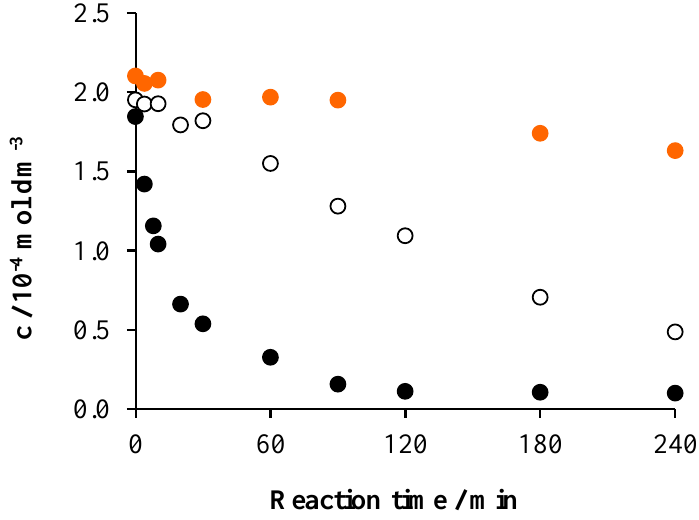
Figure 6. The change of the Triton X-100 concentration as a function of the reaction time under various conditions in the system containing 2 × 10 −4 mol·dm −3 Triton X-100 and 1 × 10 −3 mol·dm −3 Na 2 S 2 O 8 : air (•), air/UV (○) and air/UV/TiO 2 (1 g dm −3 )